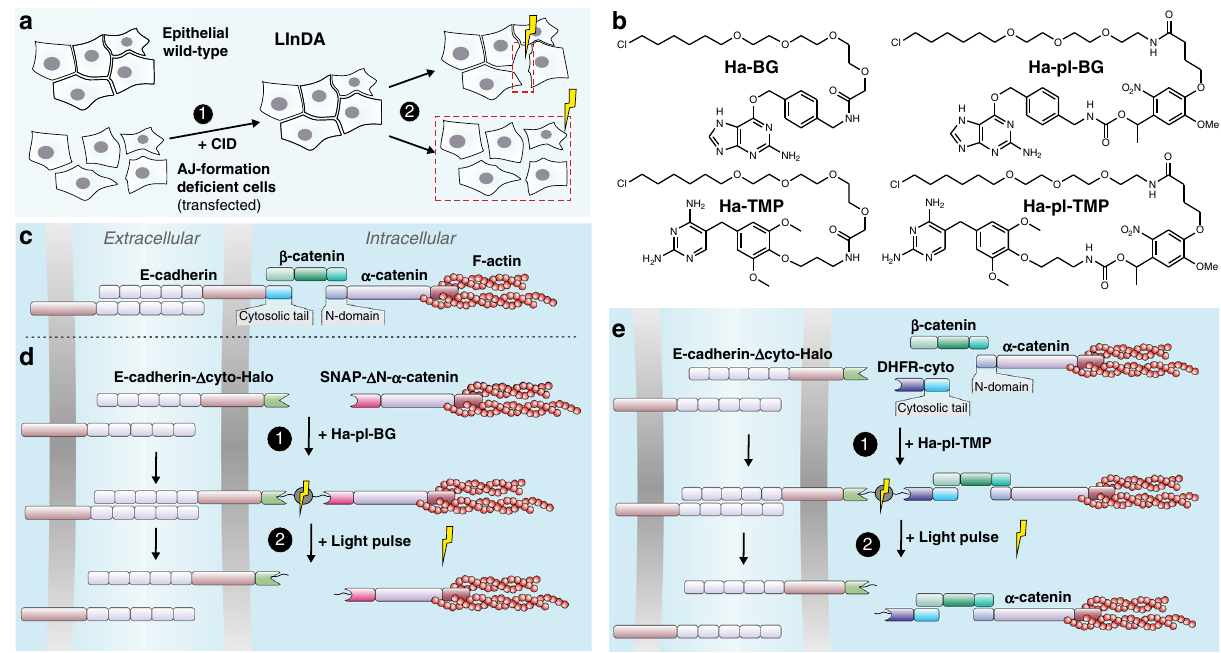
Fig. 1 Design of the setup for Light-Induced Dissociation of Adherens junctions (LInDA). a The chemically induced dimerization (CID, 1) of two different proteins or of two parts of a split variant of a protein at adherens junctions (AJ) leads to formation of functional AJs and cell compaction. The dimeric complex is cleaved with light of appropriate wavelength (350 – 405 nm) in subcellular regions or larger areas (2), leading to AJ dissociation and cell dissemination. b Chemical structures of the photostable dimerizer Ha-BG and Ha-TMP, and the photocleavable dimerizer Ha-pl-BG and Ha-pl-TMP. c In endogenous AJ, β -catenin facilitates the connection between E-cadherin and α -catenin. d The β -catenin binding domains of E-cadherin and α -catenin were replaced by Halo tag and SNAP tag, respectively. Addition of Ha-pl-BG induces the formation of an E-cadherin- α -catenin heterodimer; application of 350 – 405 nm light pulse leads to complex dissociation. e The E-cadherin receptor was split in two parts, where the cytosolic juxtamembrane domain is fused with a Halo tag and the cytosolic tail fused to a DHFR tag. Addition of Ha-pl-TMP induces the reconstitution of the receptor, the binding of β -catenin at AJs and the further recruitment of α -catenin/actin complex. The dissociation is then triggered by application of 350 – 405 nm light